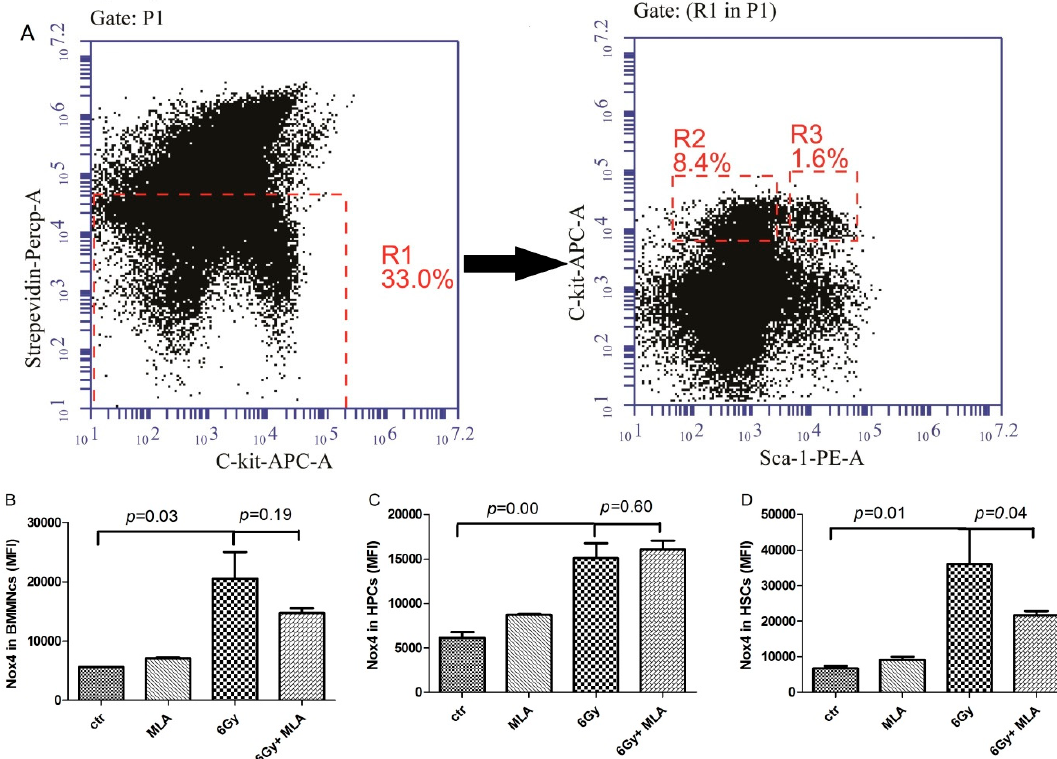
Figure 8. Effects of MLA on the expression of NOX4. ( A ) A representative flow cytometry graph: The BMMNCs(P1) were firstly gated by Strepevidin–Percp and C-kit-APC (R1), then the HPC (lin − c-kit + Sca-1 − , R2) and HSC (lin − c-kit + Sca-1 + , R3) cells were gated in the lineage negative cells (Strepevidin − ,